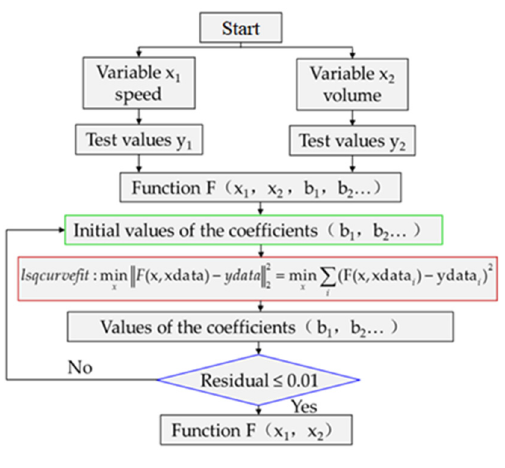
Figure 6. Method of least-squares curve fitting. The parameter identification was conducted on the basis of the procedure of least- block. The churning losses power P cm ’ obtained by least-squares curve fitting is shown